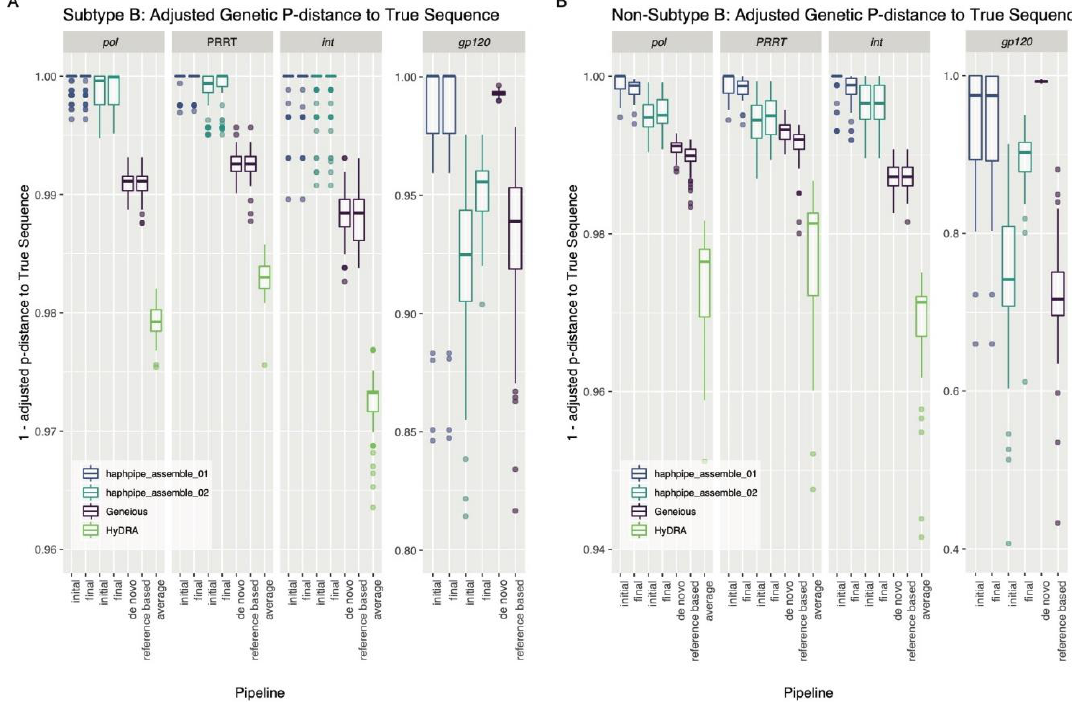
Figure 2. Adjusted genetic p-distance (displayed as a difference from 1) between consensus sequence and true sequence for all pipelines for the simulated HIV ( A ) subtype B dataset and ( B ) non-subtype B dataset. Ambiguous nucleotides were accounted for by giving fractional weight in alignment. A value closer to 1.00 indicates the consensus sequence is more genetically similar to the true sequence. The x-axis order from left to right for an individual panel: adjusted genetic p-distance between the true sequence and (i) the initial assembled sequence followed by (ii) the final assemble sequence for haphpipe_assemble_01 pipeline (de novo assembly); (iii) the initial assembled sequence followed by (iv) the final assemble sequence for haphpipe_assemble_02 pipeline (reference-based assembly); workflow; and finally, the (vi) average between the final two sequences (one for each read file) for HyDRA. The three amplicons are shown, as well as a combination of PRRT and int amplicons into pol